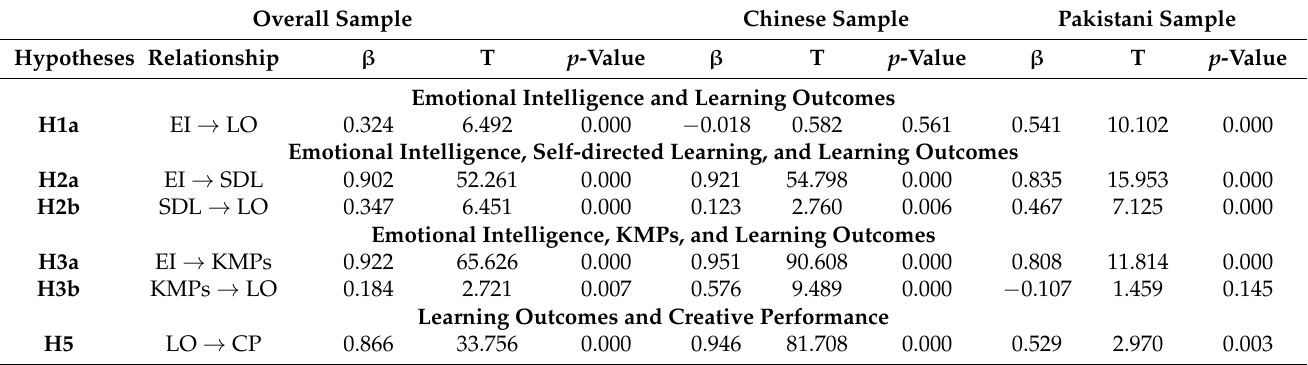
Table 7. Results of Structural Model Path Coefficient (Direct Relationships).